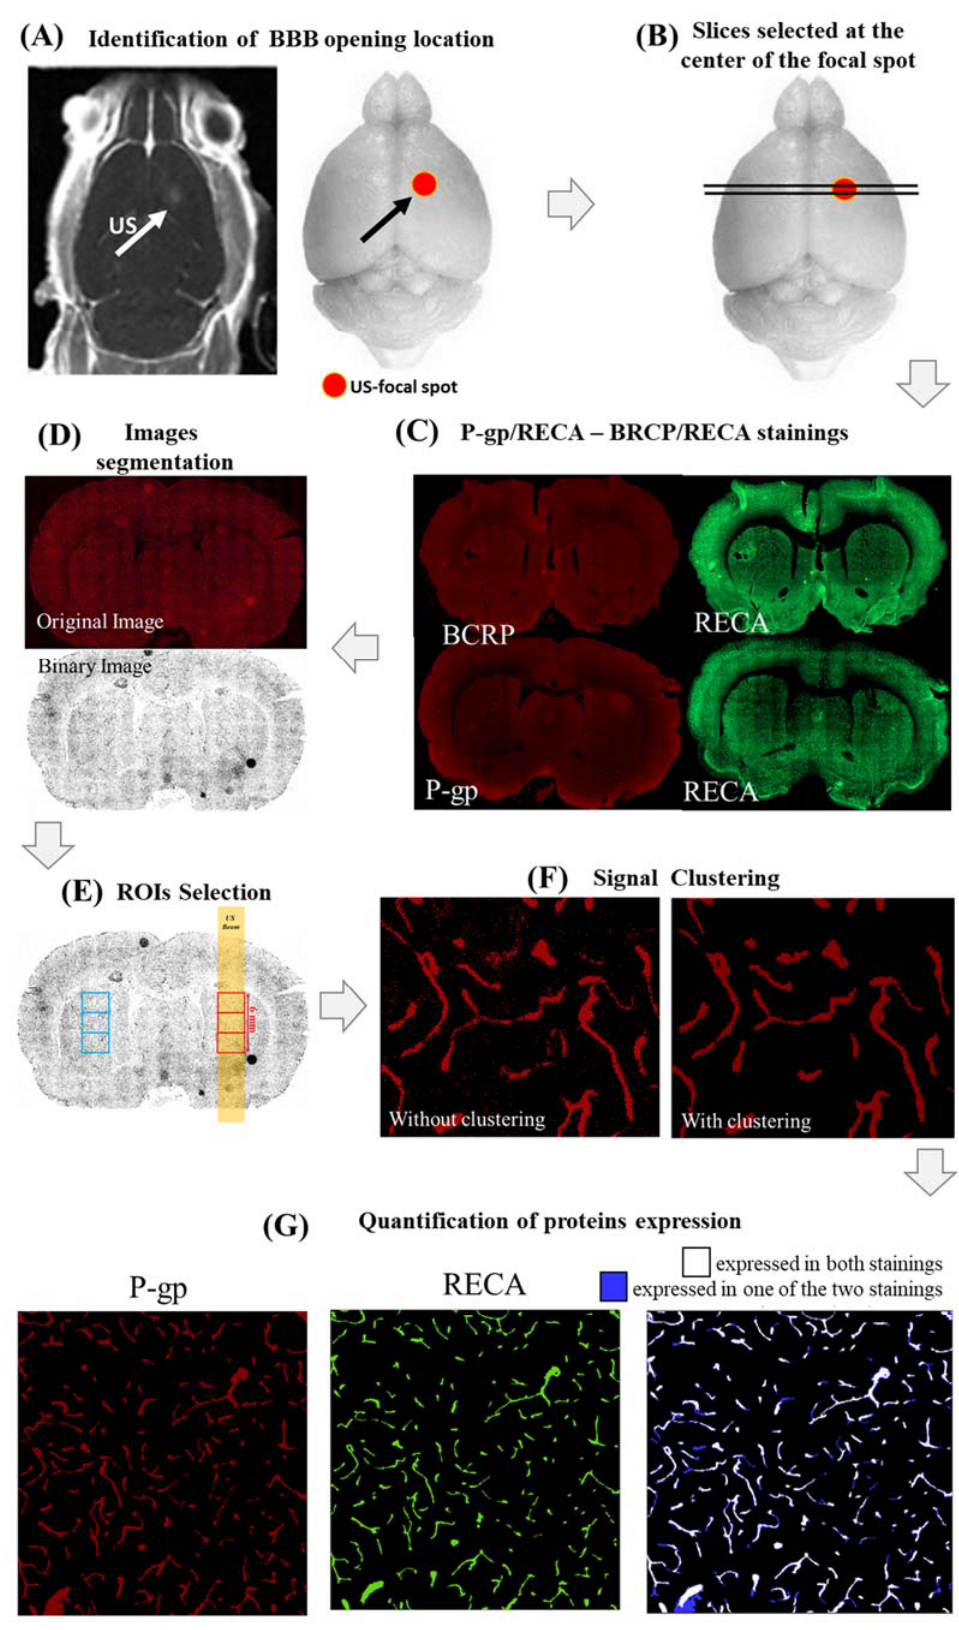
Figure 5. Pipeline used to evaluate P-gp, BCRP, and RECA expressions in rat brains after FUS. In all cases, the center of the focal spot was identified in the postcontrast T 1 -w images acquired right